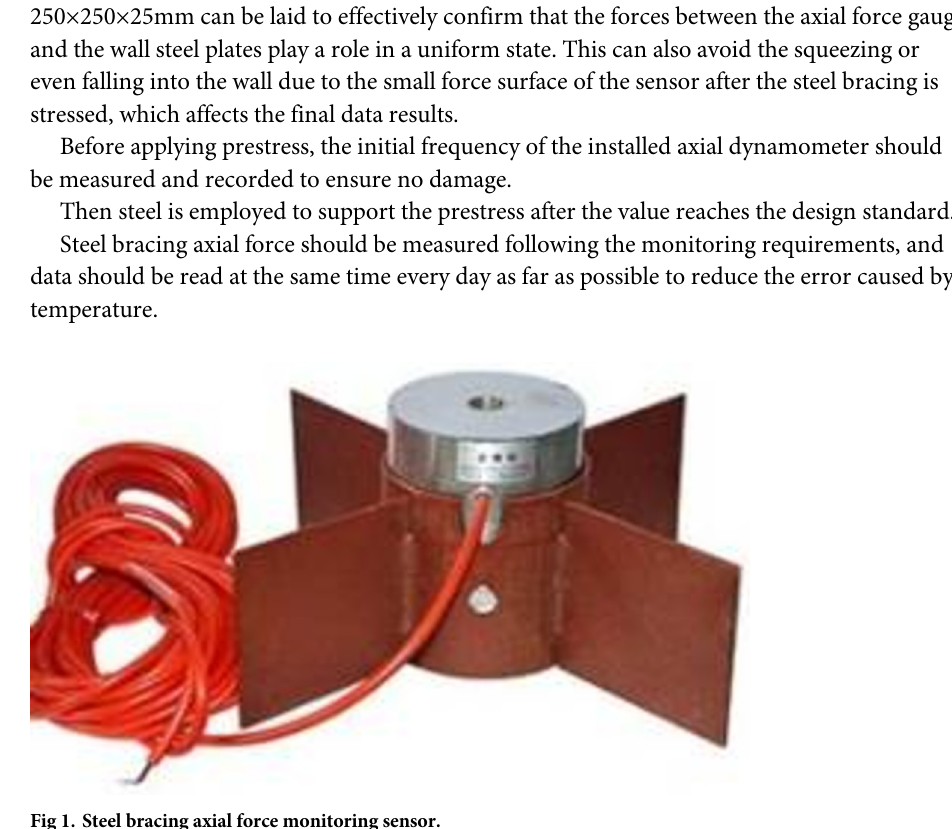
Fig 1. Steel bracing axial force monitoring